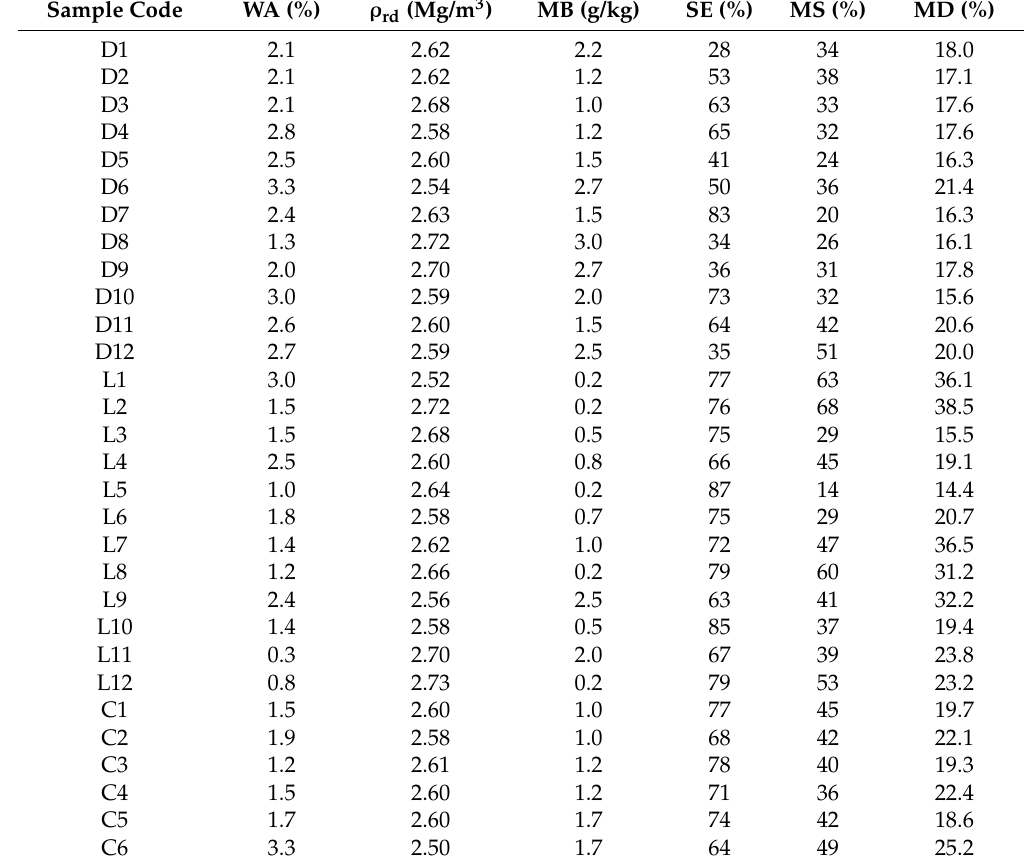
Summary of fine aggregate physicomechanical properties.